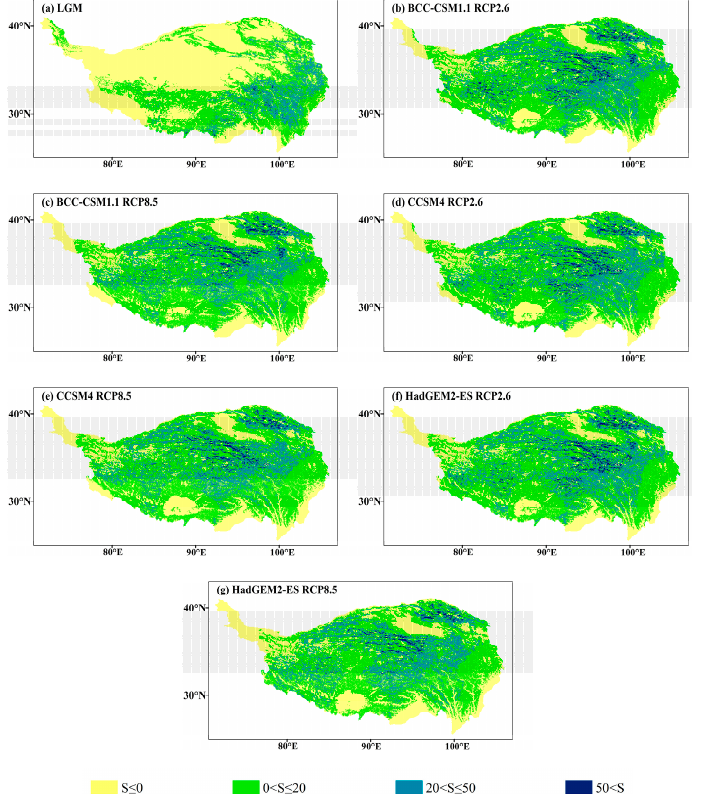
Figure 9. Multivariate environmental similarity surface (MESS) for J. tibetica during different periods. ( a ) MESS for the LGM; ( b ) MESS for the BCC-CSM1.1 (RCP2.6); ( c ) MESS for the BCC-CSM1.1 (RCP8.5); ( d ) MESS for the CCSM4 (RCP2.6); ( e ) MESS for the CCSM4 (RCP8.5); ( f ) MESS for the HadGEM2-ES (RCP2.6); ( g ) MESS for the HadGEM2-ES